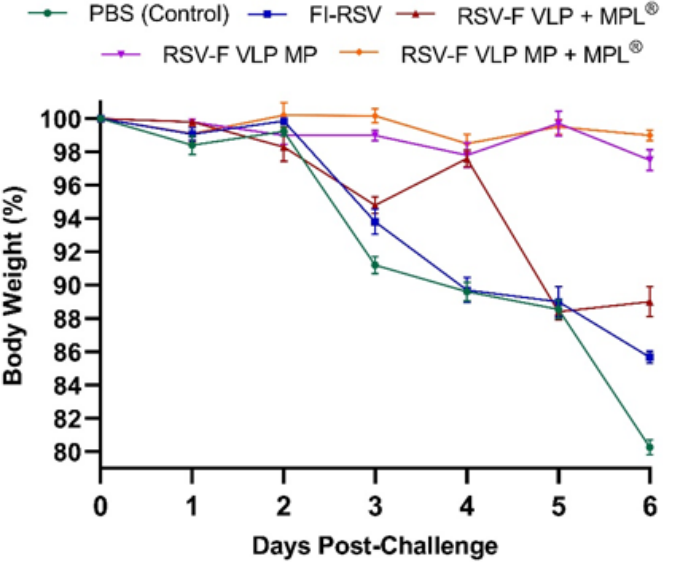
Figure 4. Body weight changes. Vaccinated mice ( n = 5) were challenged with live RSV-A2 virus. The body weights were monitored daily, where 100% body weight was considered for day